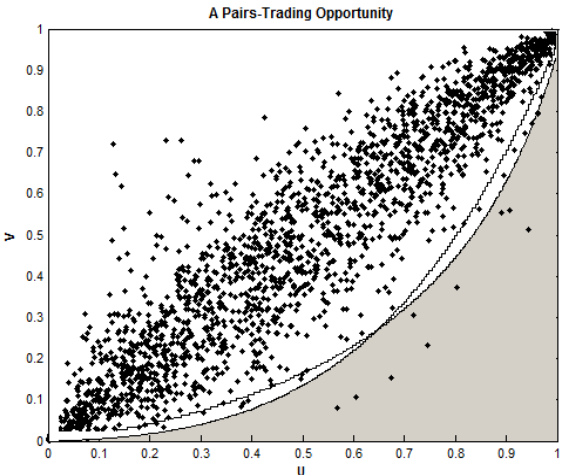
FIGURE 3: An illustration of the area where pairs-trades can be executed when using a 99% confidence level and the N14 copula dependence